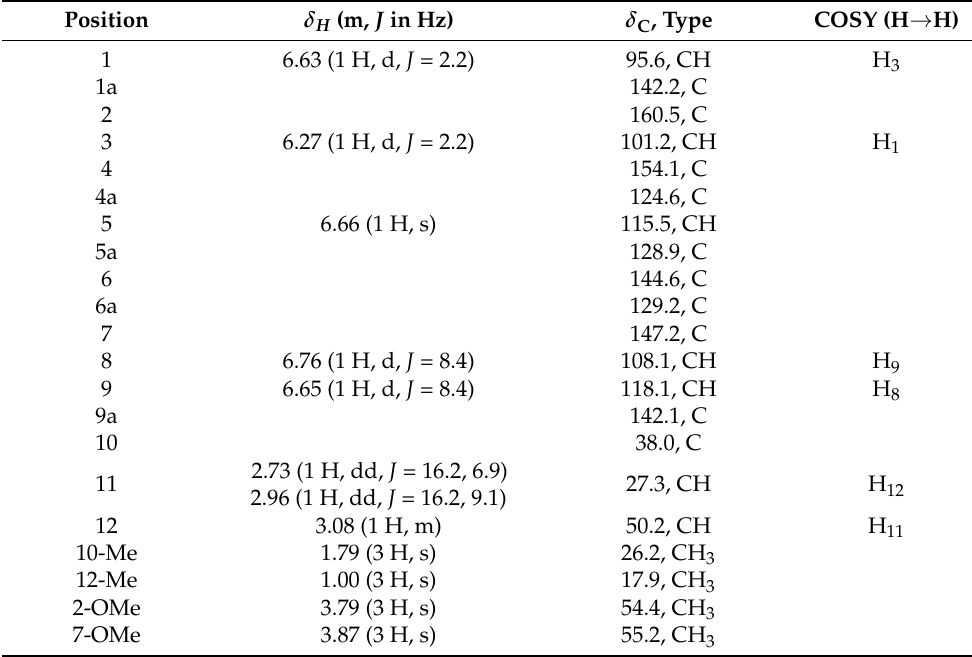
Table 4. NMR spectroscopic data for compound 2 (400 MHz, Methanol- d 4 ).